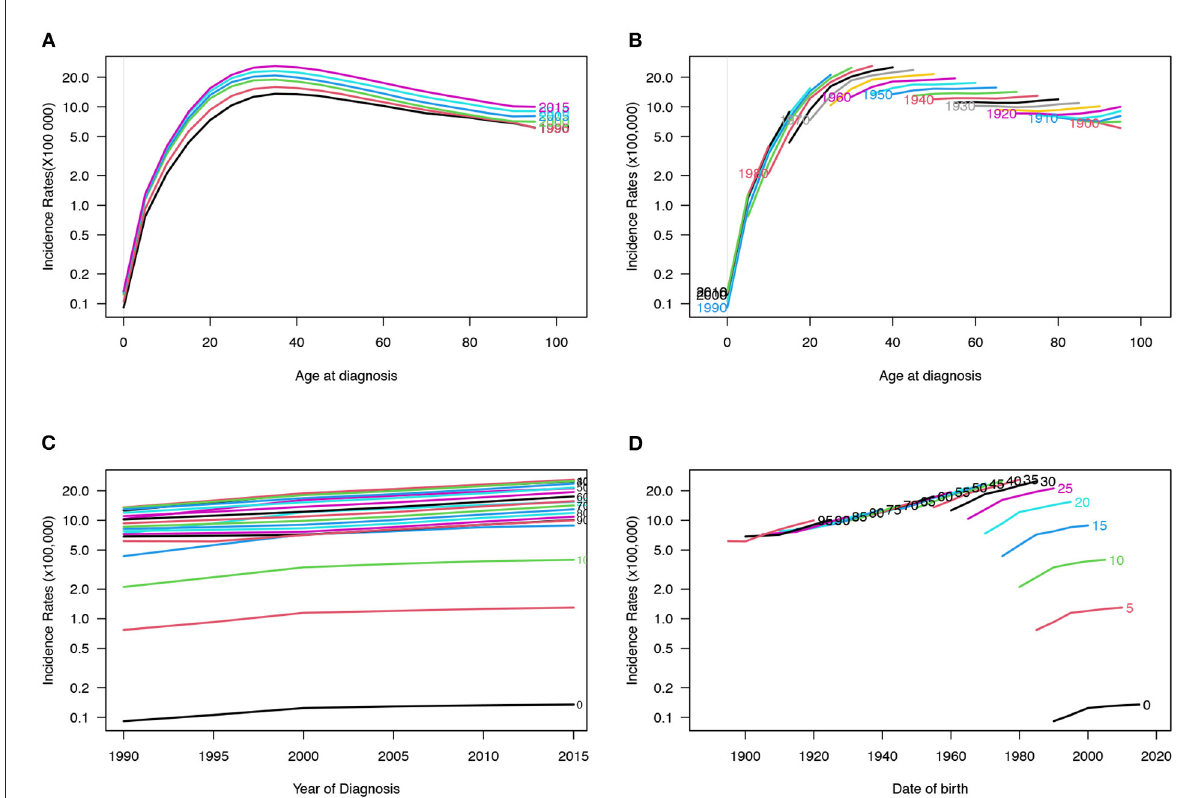
FIGURE5 Incidence rates of IBD in China. (A) The age-specific incidences rates of IBD according to time periods; each line connects the age-specific incidence for a 5-year period. (B) The age-specific incidences rates of IBD according to birth cohort; each line connects the age-specific incidence for a 5-year cohort. (C) The period-specific incidence rates of IBD according to age groups; each line connects the birth cohort-specific incidence for a 5-year age group. (D) The birth cohort-specific incidence rates of IBD according to age groups; each line connects the birth cohort-specific incidence for a 5-year age